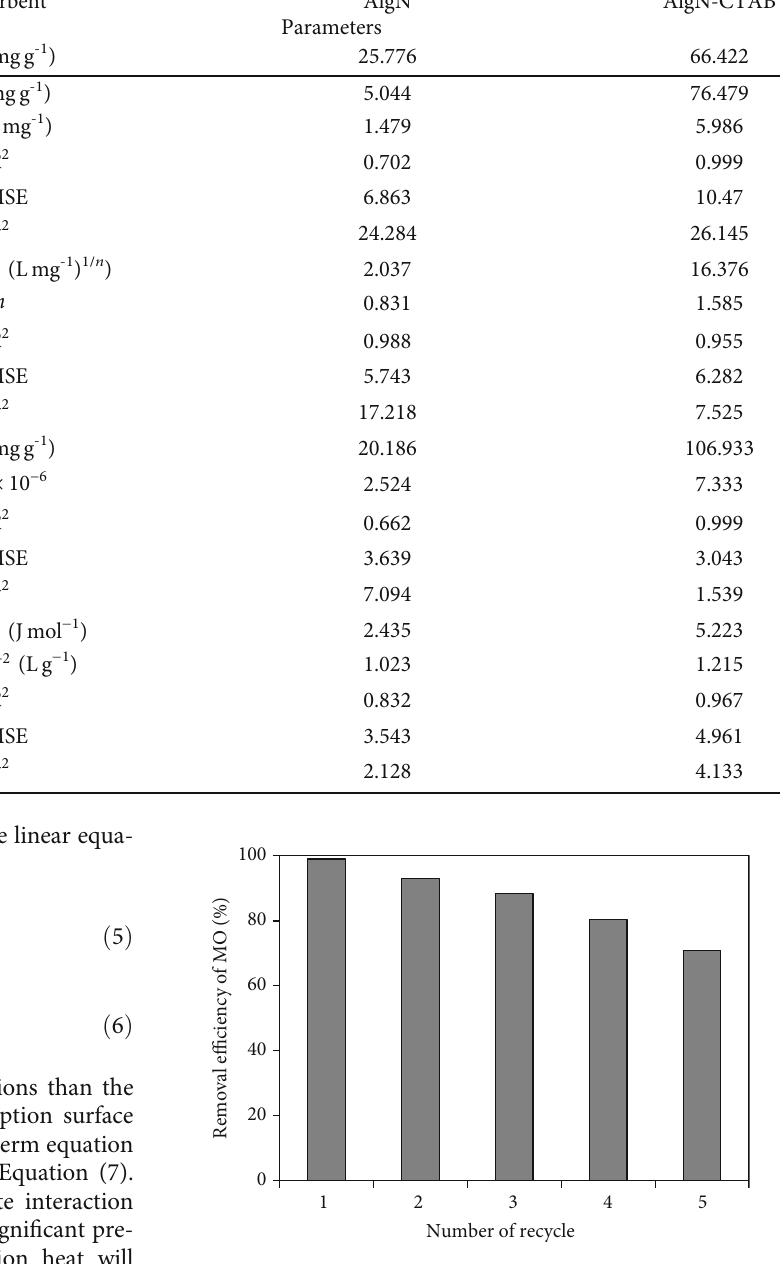
Figure 11: Reusability number e ffi ciency of the adsorption of MO on